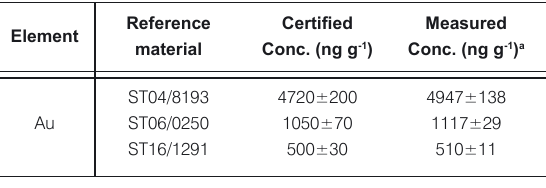
Table 4. Determination of Au in certified reference samples using the developed procedure using brilliant green as a complexing agent.